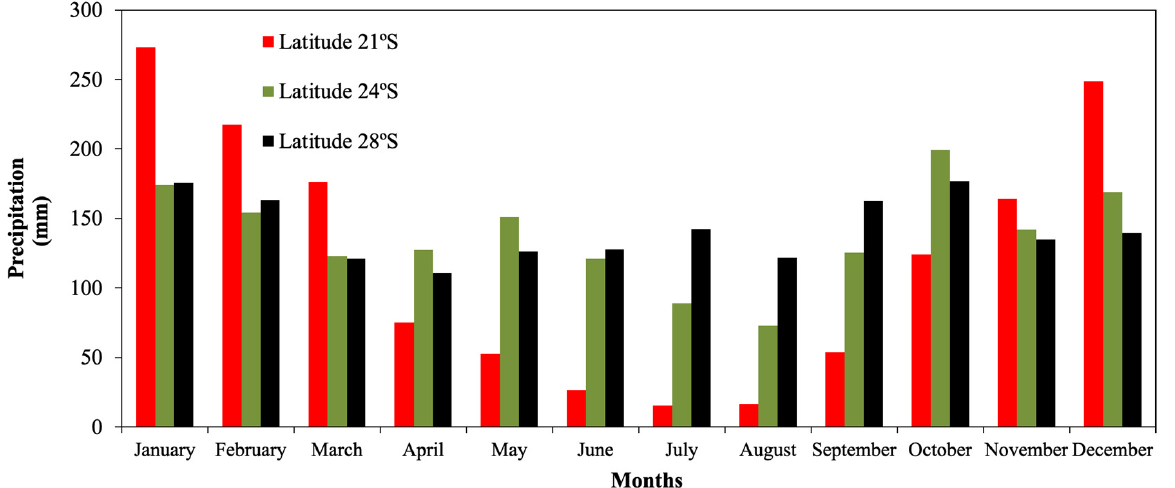
Figure 6. Monthly precipitation (mm) throughout the year in three locations in Brazil: Lages, Santa Catarina state (latitude 28° S), Palotina, Parana state (24° S), and Ribeirao Preto, Sao Paulo state (21° Catarina state (latitude 28 ◦ S), Palotina, Parana state (24 ◦ S), and Ribeirao Preto, Sao Paulo S). A 25 km buffer was generated around each region to obtain monthly data from 1982 to 2021.